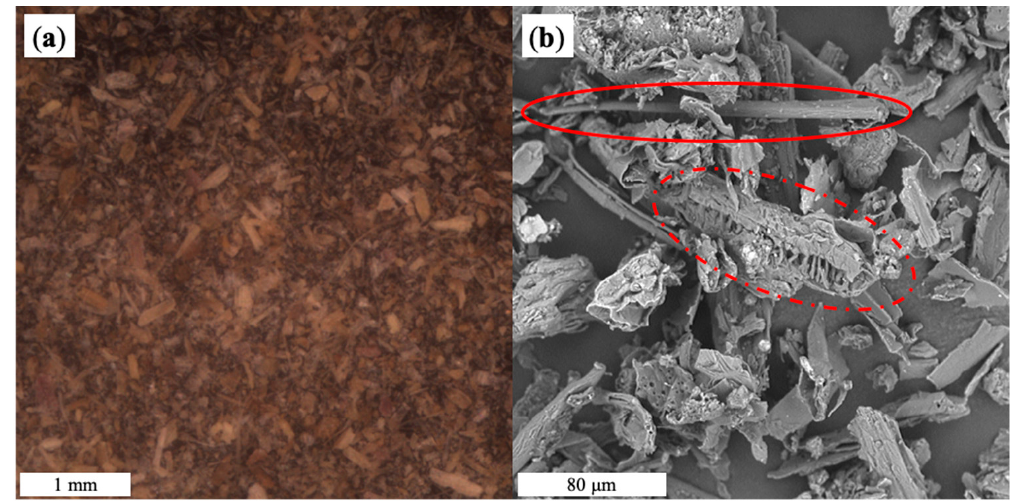
Figure 3. Optical image ( a ) and SEM micrograph ( b ) of HC powder.